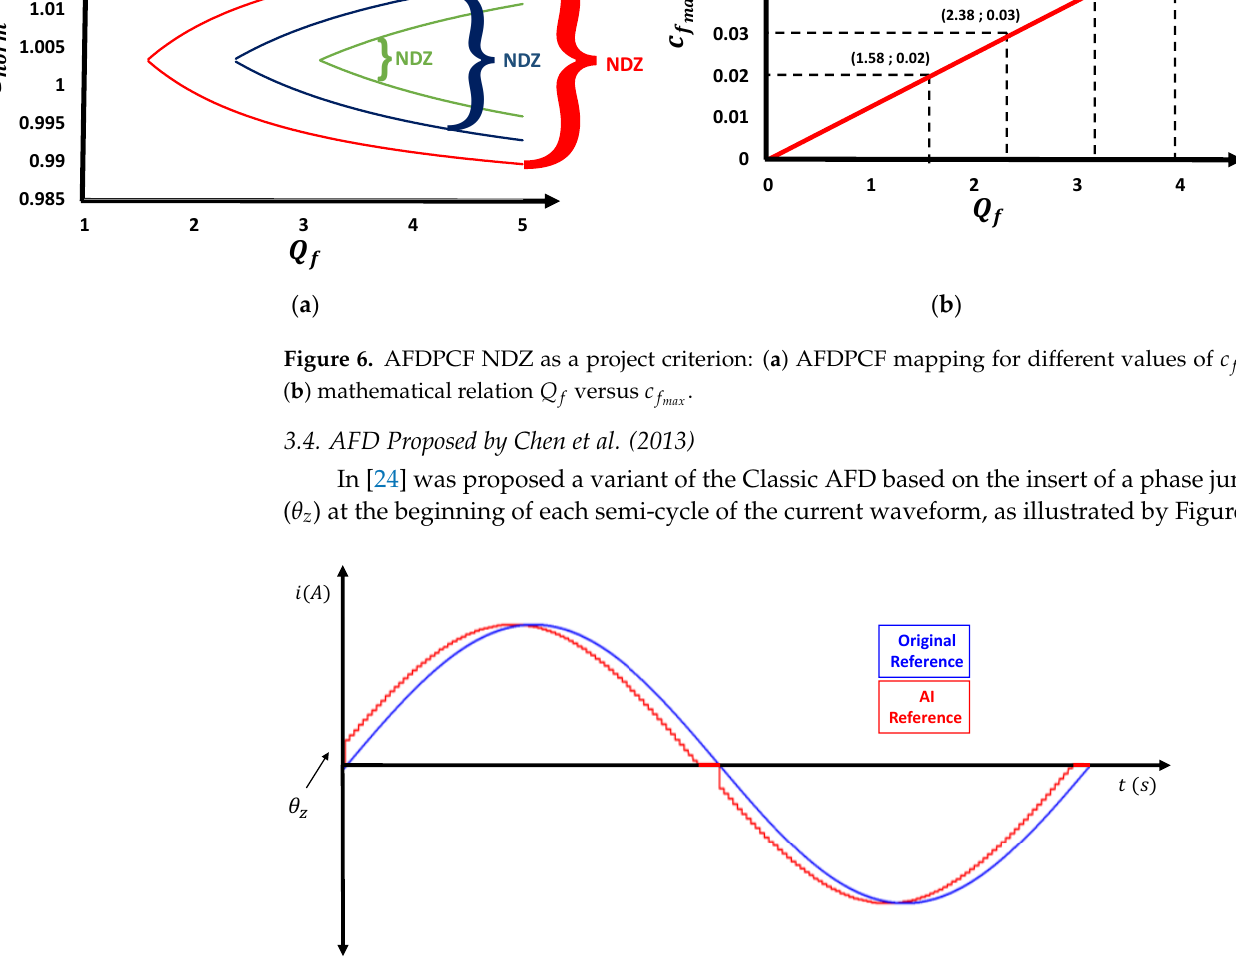
Figure 7. Current waveform reference of the AFD proposed by [24].